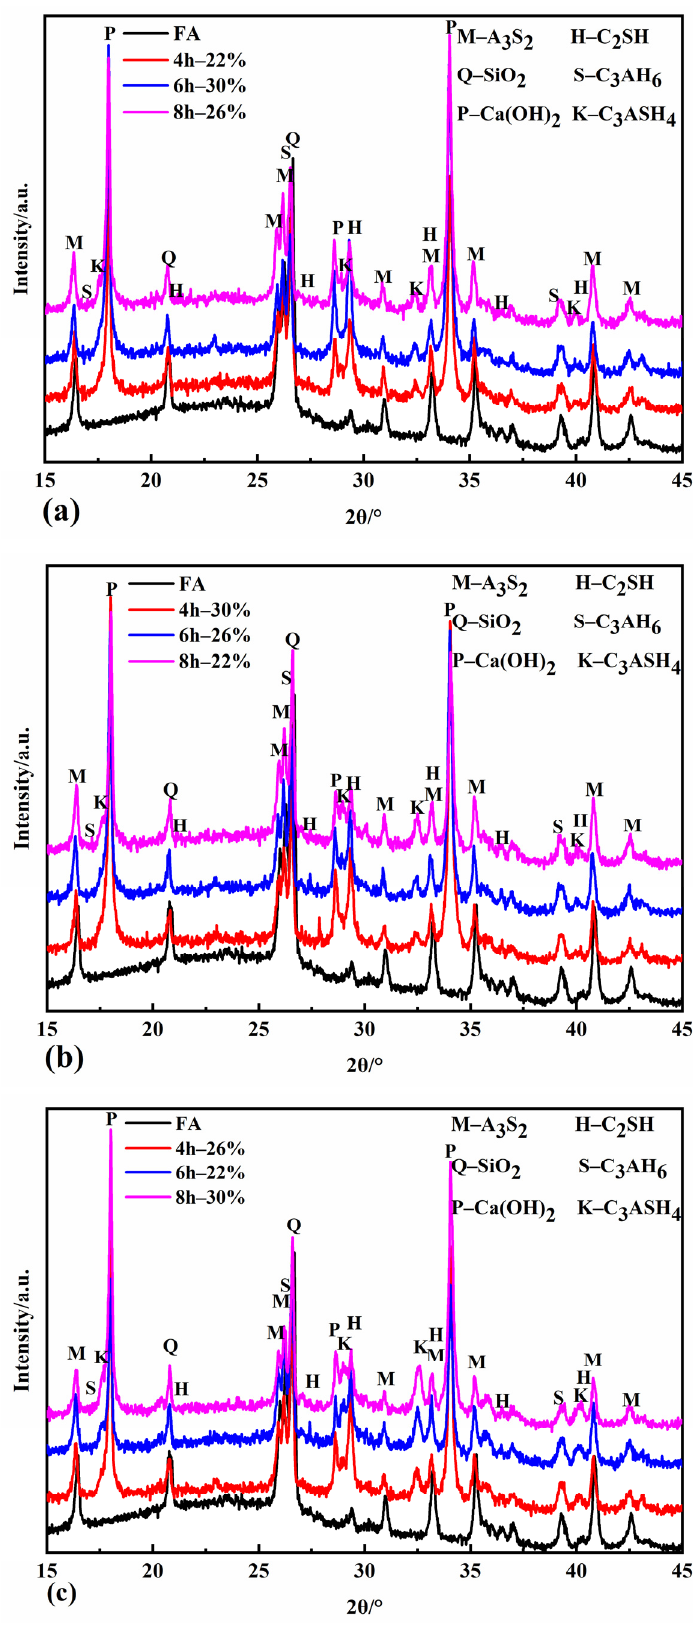
◦ C ( a ), 140 ◦ C ( b ), and 160 ◦ C ( c